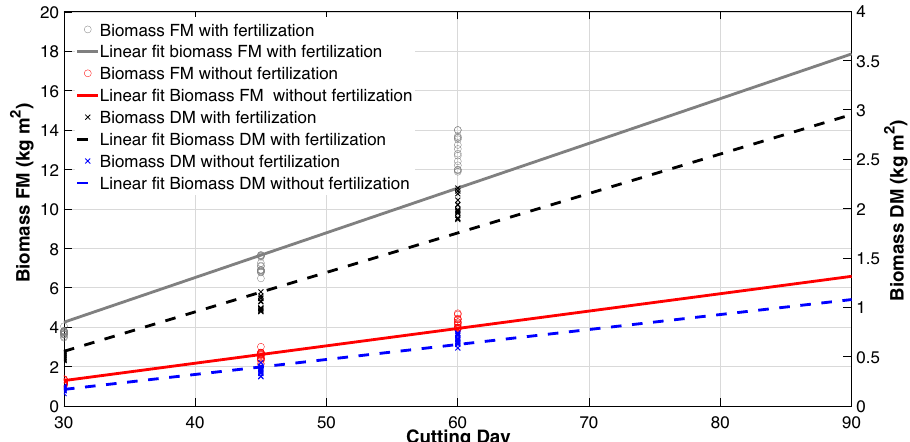
Figure 1. Linear relationship between biomass production of King grass on different cutting days and in systems with and without fertilization. Plots were created in MATLAB R2021a. FM fresh matter, DM dry matter. Linear regression equation ( C cutting day): Biomass FM with fertilization = 0.2269 C − 2.5525, r 2 = 0.9238, n = 63, P < 0.001. Biomass FM without fertilization = 0.0882 C − 1.352, r 2 = 0.9784, n = 63, P < 0.001. Biomass DM with fertilization = 0.03998C − 0.6448, r 2 = 0.9263, n = 63, P < 0.001. Biomass DM without fertilization = 0.01517